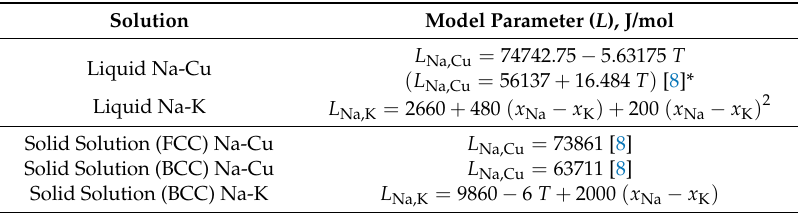
Table 1. The model parameters used to describe the